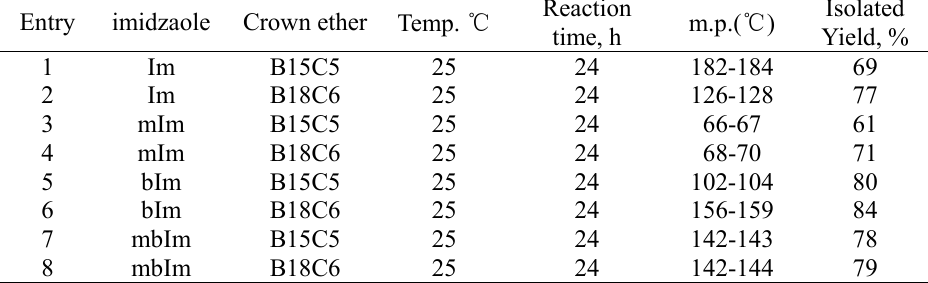
Table 1. Synthesis of crown ether functionalized